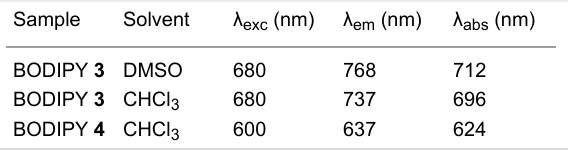
Table 1: Photophysical data for BODIPY 3 and 4 , absorption maximum ( λ abs ), and emission maximum ( λ em ).